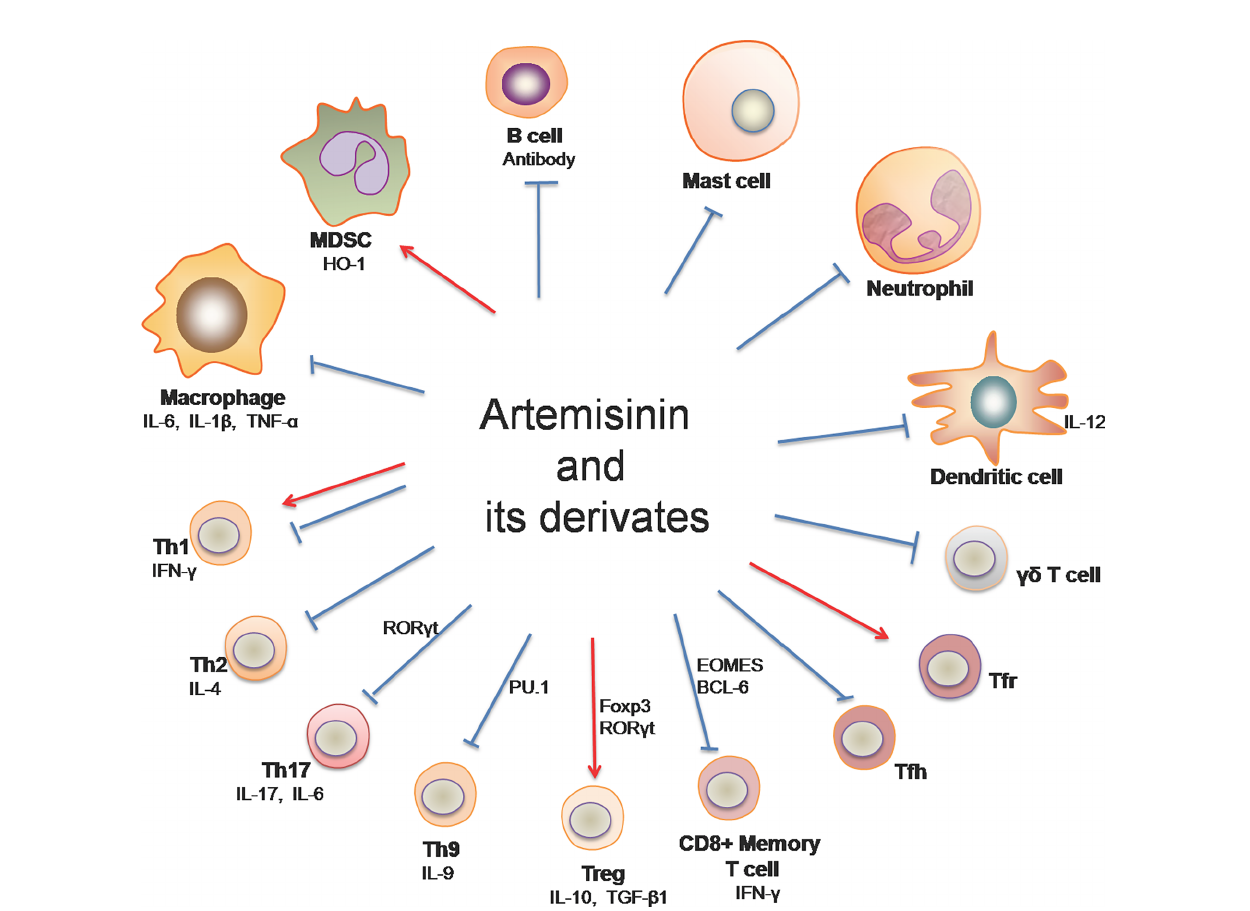
FIGURE 1 | Artemisinin and its derivatives on both adaptive and innate immune cells. Artemisinin and its derivatives have the capacity to regulate expressions of proin fl ammatory and anti-in fl ammatory cytokines, the frequency and activation of T helper and B cells, and the responsiveness of macrophages, DCs, neutrophils, mast cells and MDSCs. “ ↓ “ denotes “ enhancing ” while “ ⊥ “ indicates “ suppressing ” . (Th1, T helper 1 cell; Th2, T helper 2 cell; Th9, T helper 9 cell; Th17, T helper 17 cell; Treg, regulatory T cells; Tfh, follicular helper T cells; Tfr, follicular regulatory T cells; MDSC, myeloid-derived suppressor